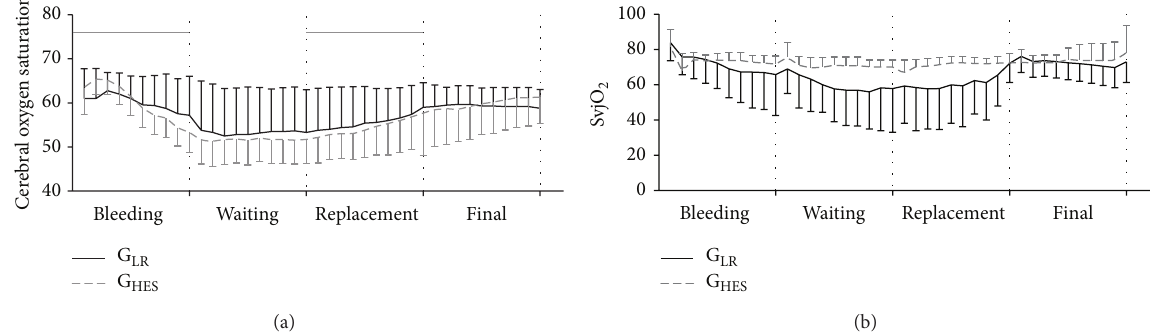
Figure 1: Propofol plasma concentration ( 𝐶 𝑝 — 𝜇 g/mL) and propofol free metabolites ( 𝐶 The two groups are shown: G LR —black line and G HES —dashed grey line.